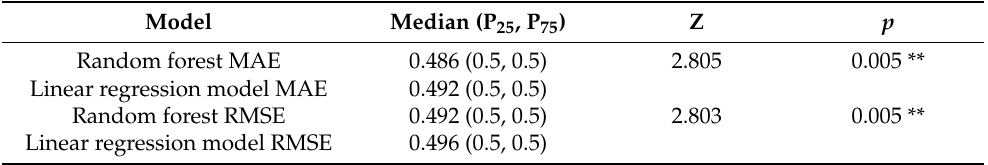
Table 4. Results of Wilcoxon analysis of MAE and RMSE for random forest and linear regression models. Model Median (P 25 , P 75 ) Z p Random forest MAE 0.486 (0.5, 0.5) 2.805 0.005 ** Linear regression model MAE 0.492 (0.5, 0.5) Random forest